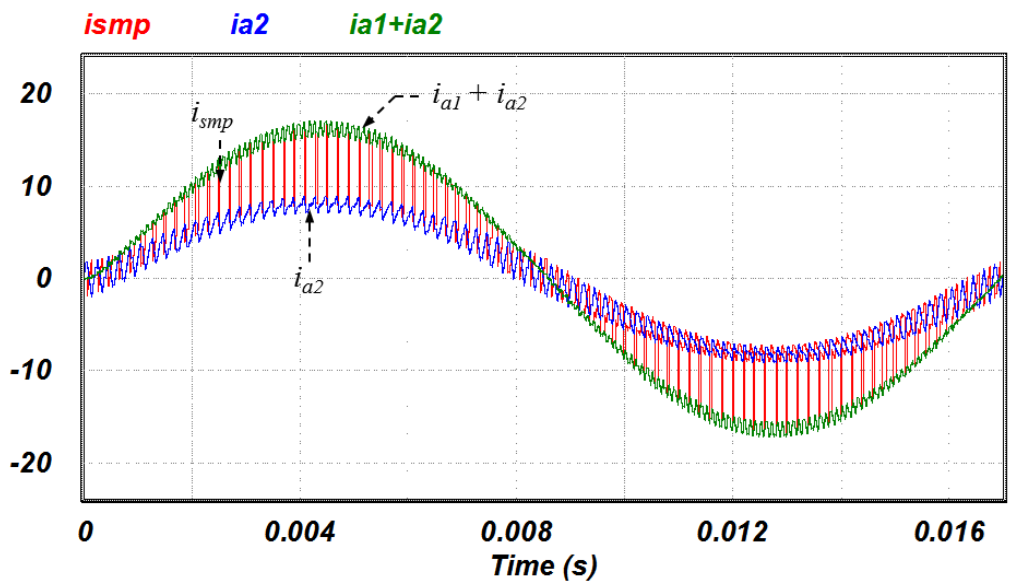
Figure 4. Simulation result that shows the current sensor output with the actual currents.